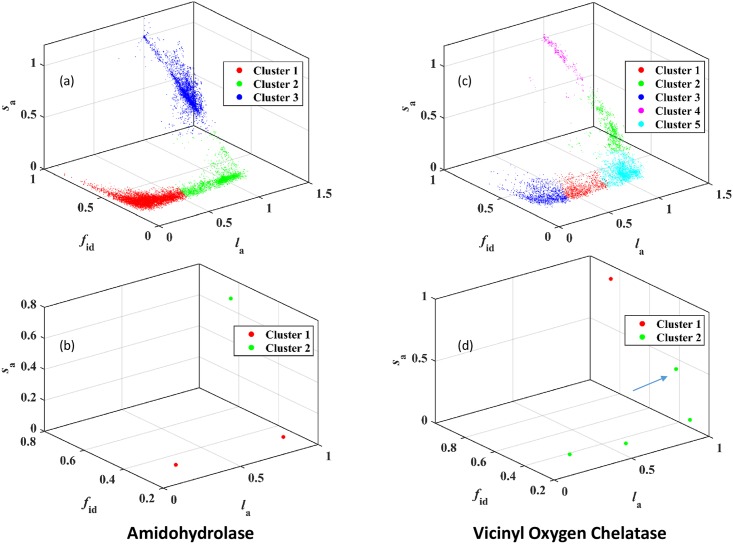
Partition of attribute vectors and mean attribute vectors into clusters by k-means clustering.(a) Cluster assignment for each attribute vector from the Amidohydrolase superfamily, (b) Assignment of each clusters mean attribute vector for the Amidohydrolase superfamily to Region 1 or otherwise, (c) Cluster assignment for each attribute vectors from the Vicinyl Oxygen Chelatase superfamily, and (d) Assignment of cluster mean attribute vector for the Vicinyl Oxygen Chelatase superfamily. Clusters with highest sa values exceeding 0.3 are included in Region 1 for both superfamiles. An error in cluster assignment to Region 1 is indicated in (d) with an arrow and is corrected in the analysis.